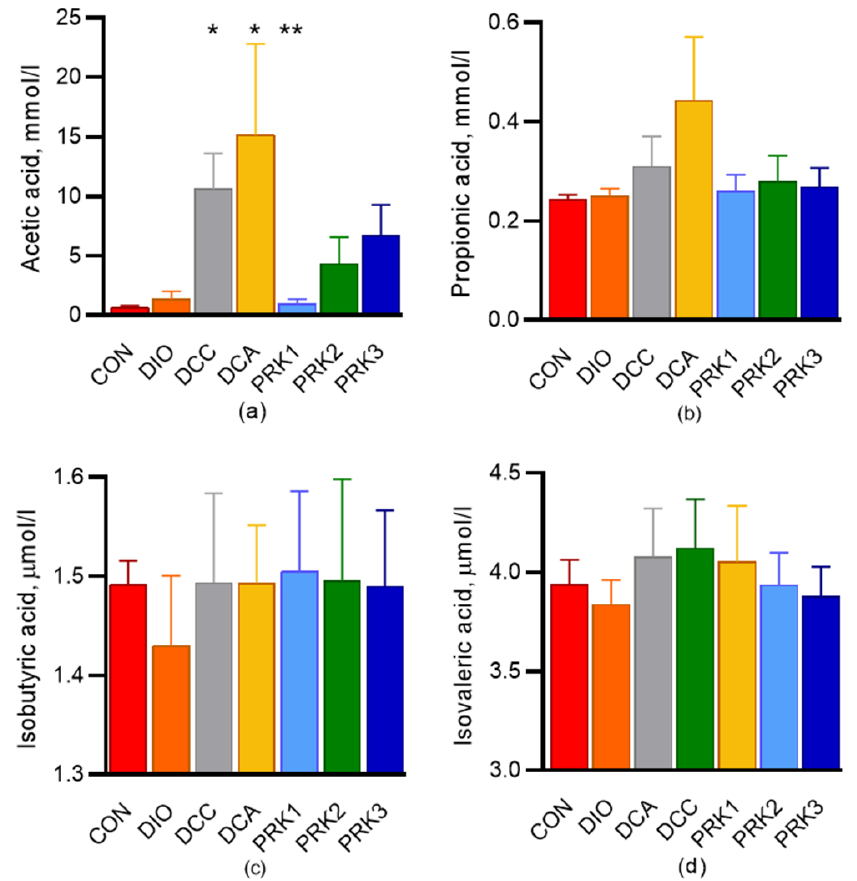
Figure 4. Effects of different treatments on plasma concentration of short-chain fatty acids. Plasma concentrations of ( a ) acetic, ( b ) propionic, ( c ) isobutyric, and ( d ) isovaleric acid were determined by GC–FID. Data are presented as mean ± standard deviation. * indicates p < 0.05 when data is compared to that for the CON group; ** indicates p < 0.05 when data is compared to that for the DCA group.